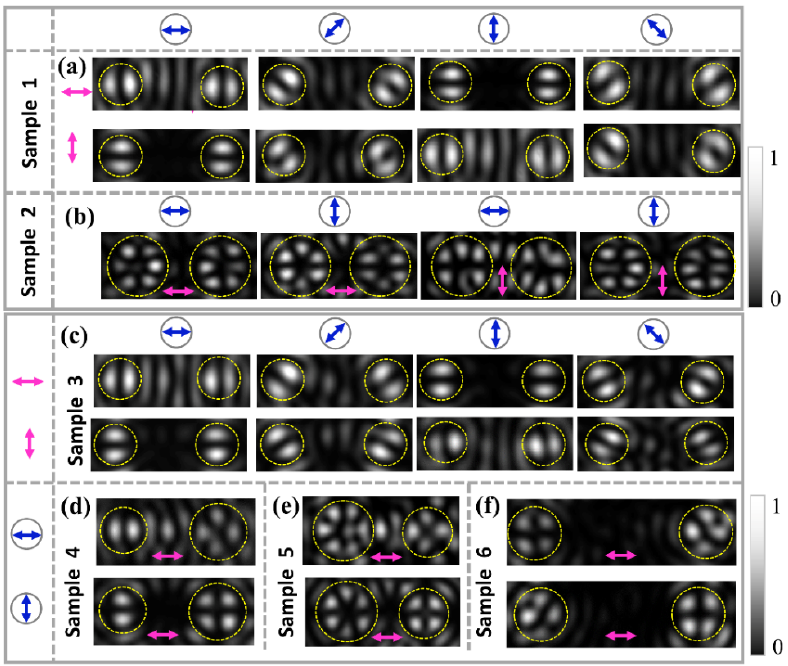
Figure 7. The experimental intensity patterns of different dual-channel FVBs. ( a ) The dual-channel FVBs of orders l l = l r = 1 for the Sample 1 under illumination of horizontal and vertical polarization, respectively. ( b ) The dual-channel FVBs of orders l l = l r = 3 for Sample 2 under illumination of horizontal polarization. ( c ) The FVBs of order l l = 1 and l r = −1 for Sample 3 under illumination of horizontal and vertical polarization, respectively. ( d – f ) The dual-channel FVBs of orders l l = 1 and l r = 2 for Sample 4, l l = 3 and l r = 2 for Sample 5, and l l = l r = 2 for Sample 6, respectively, under illumination of horizontal polarization. The magenta double arrows represent the linear polarization of illumination light, and the blue double arrows in circles indicate the transmission axis of the analyzing polarizer P.